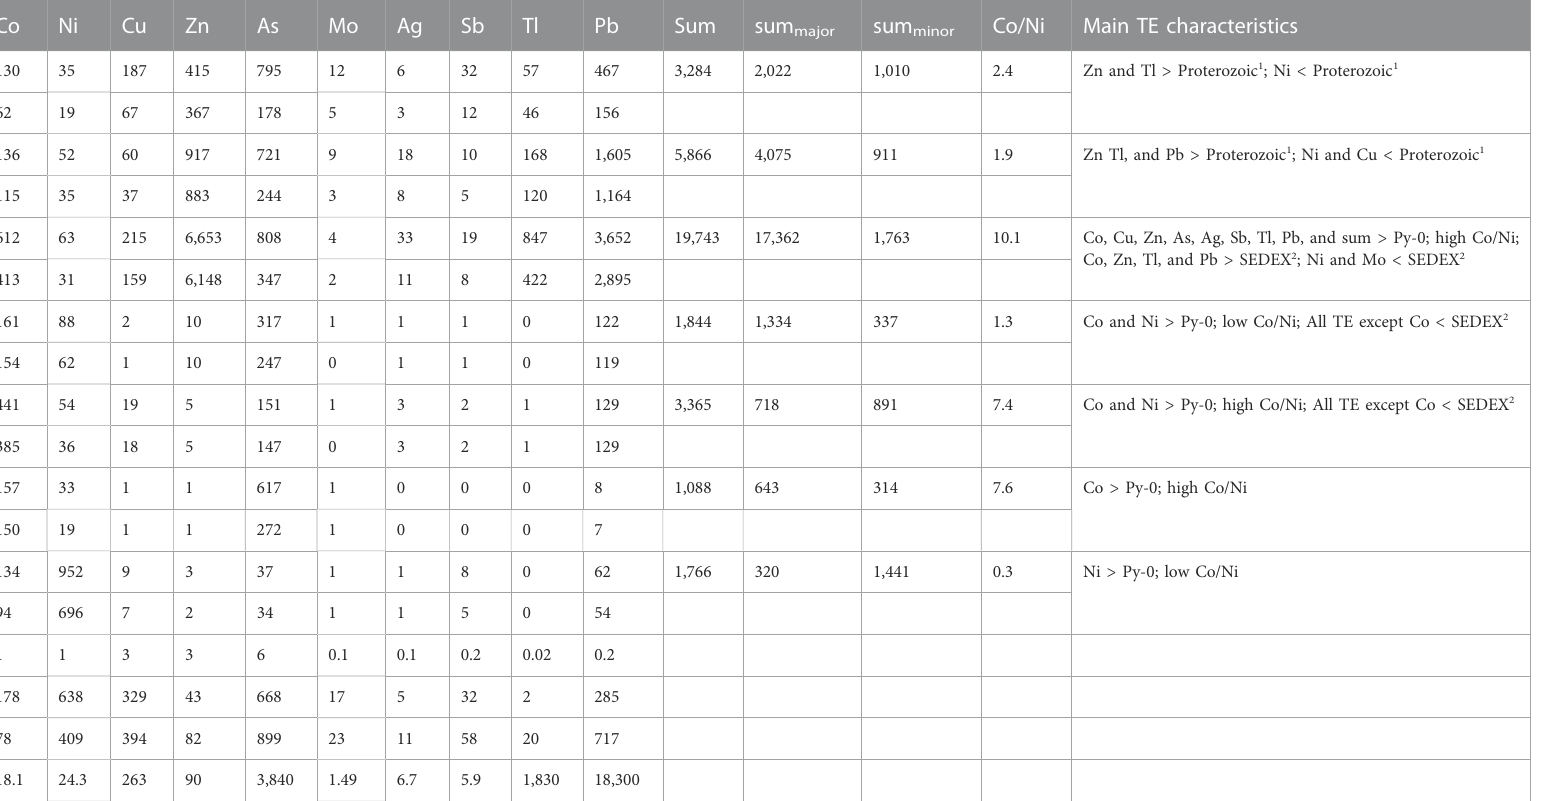
TABLE 1 Summary of LA-ICP-MS